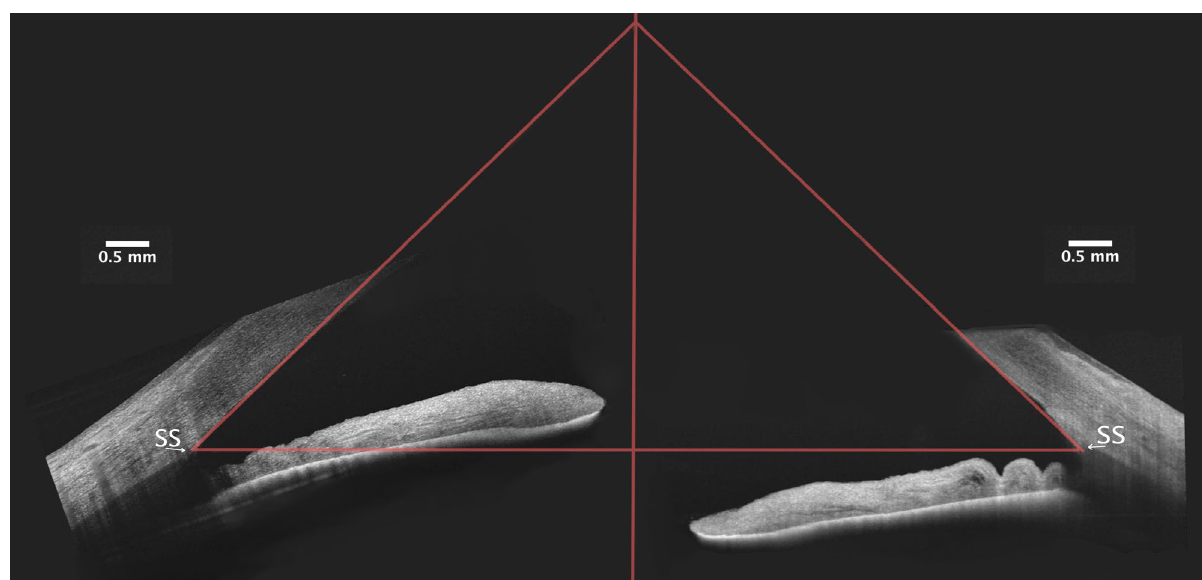
Figure 1. ACA before (left) and 6 months after (right) phacoemulsification and IOL implantation. The orientation of tomograms was adjusted for demonstrational purposes. Both of the sides represented temporal tomogram of the right eye pre- (left) and postoperatively (right). The lining point in both tomograms was the sclera spur (SS). Preoperatively, iris had more upward orientation than postoperatively. The ACA was open pre- and postoperatively. (Images acquired with DRI OCT Triton plus